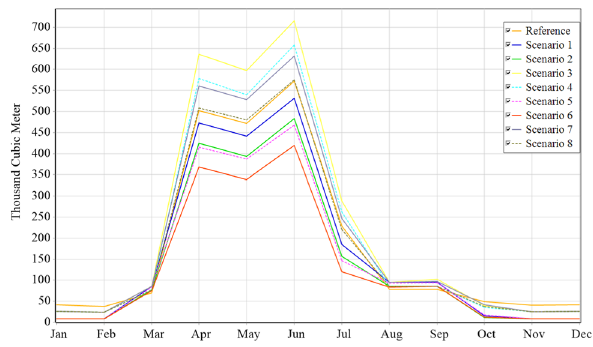
Fig. 3 The average monthly change in water